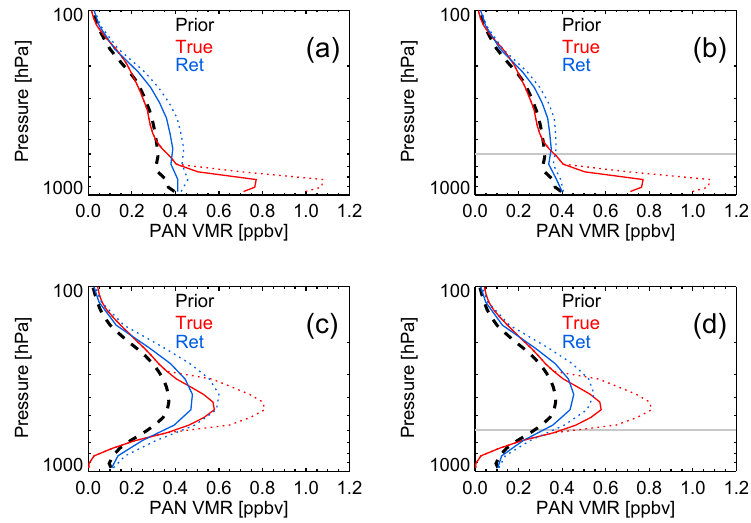
Figure 1. Simulated TES PAN retrievals for four different hypothetical conditions where the black dashed line shows the prior, the two red lines show two different true profiles, and the two blue lines show the retrieved profiles. The true profile exhibits a maximum in the volume mixing ratio (vmr) close to the surface in the upper panels ( a and b ), while the true profile peaks in the mid-troposphere in the lower panels ( c and d ). Panels on the left ( a and c ) show clear-sky retrievals while panels on the right ( b and d ) show retrievals where a cloud with effective optical depth of 0.7 is placed at 600hPa (dotted line). Corresponding averaging kernels are provided in the